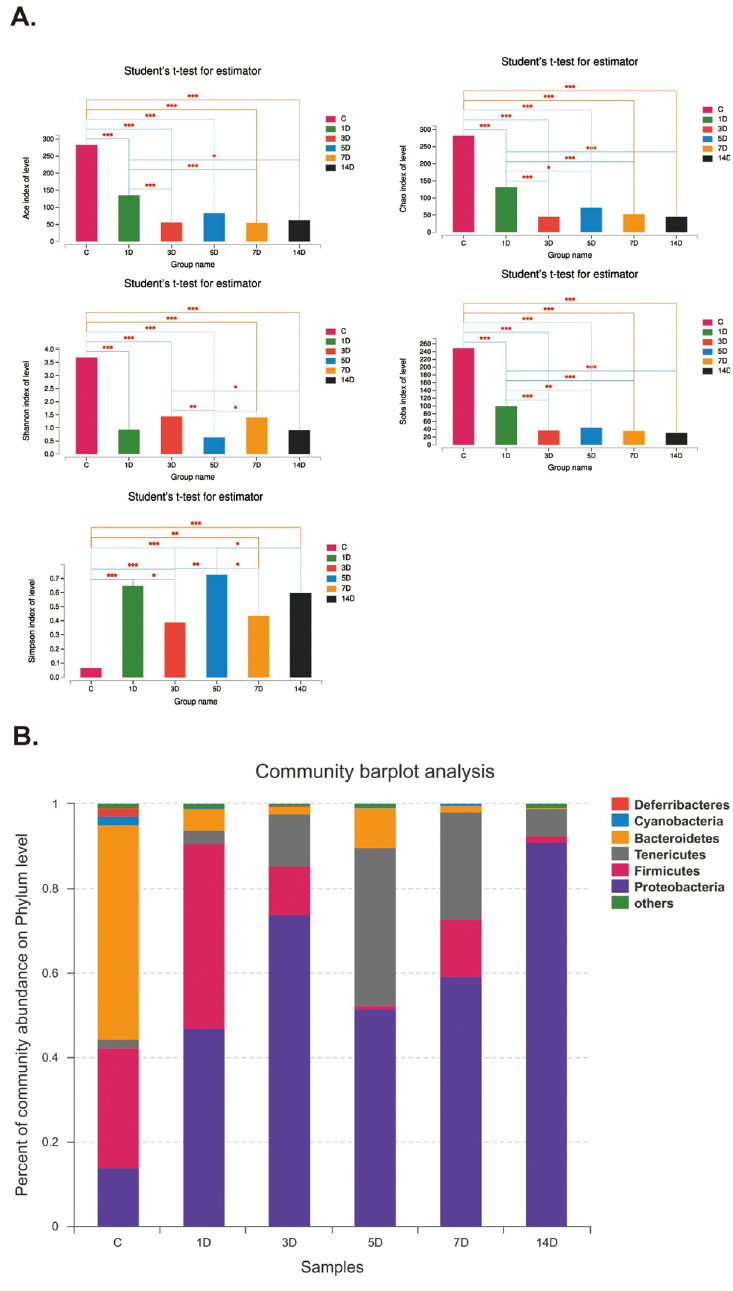
Fig 1. Antibiotics alters diversity and composition of intestinal microbiota. A. Antibiotics statistically reduced Ace, Chao, Shannon and Sobs, which are the indices of intestinal microbiota. � p < 0.05, ��� p < 0.001 compared with control. B. Percent of community abundance on phylum level. Antibiotics significantly increased the percentage of Proteobacteria.